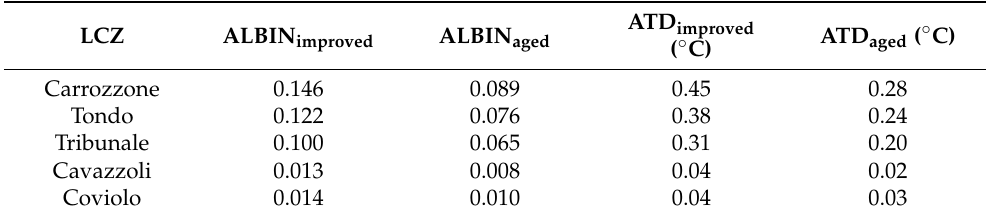
Table 9. Increase in the albedo value (ALBIN) for the improved and aged scenarios and subsequent air temperature decrease